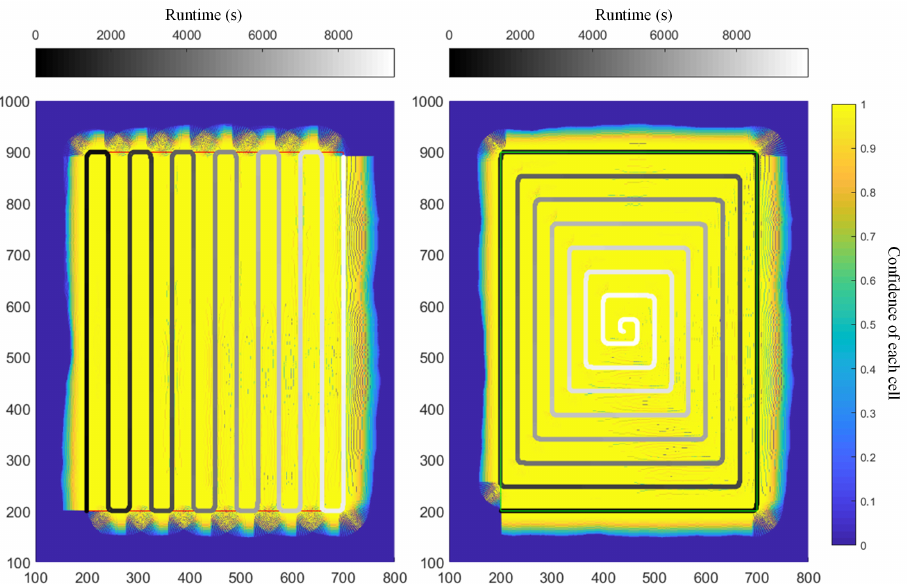
Figure 9. Simulation results of a lawnmower path ( left one ) and a spiral path ( right one ). For the former, the inter-distance between the transects is 42 m. For the latter, the inter-distance between the zonal transects is 46 m, and the inter-distance between the meridional transects is 33